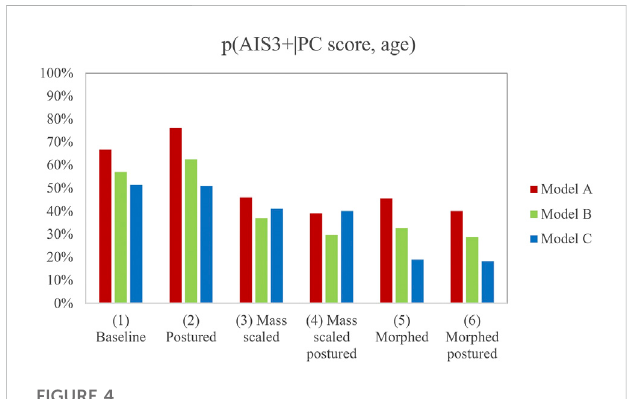
FIGURE 4 Probability of AIS3+ for the different model versions based on the PC Score metric. Note that there are 18 results to account for the differences in the position of the upper chest landmarks between PMHS A and B in the experiments.